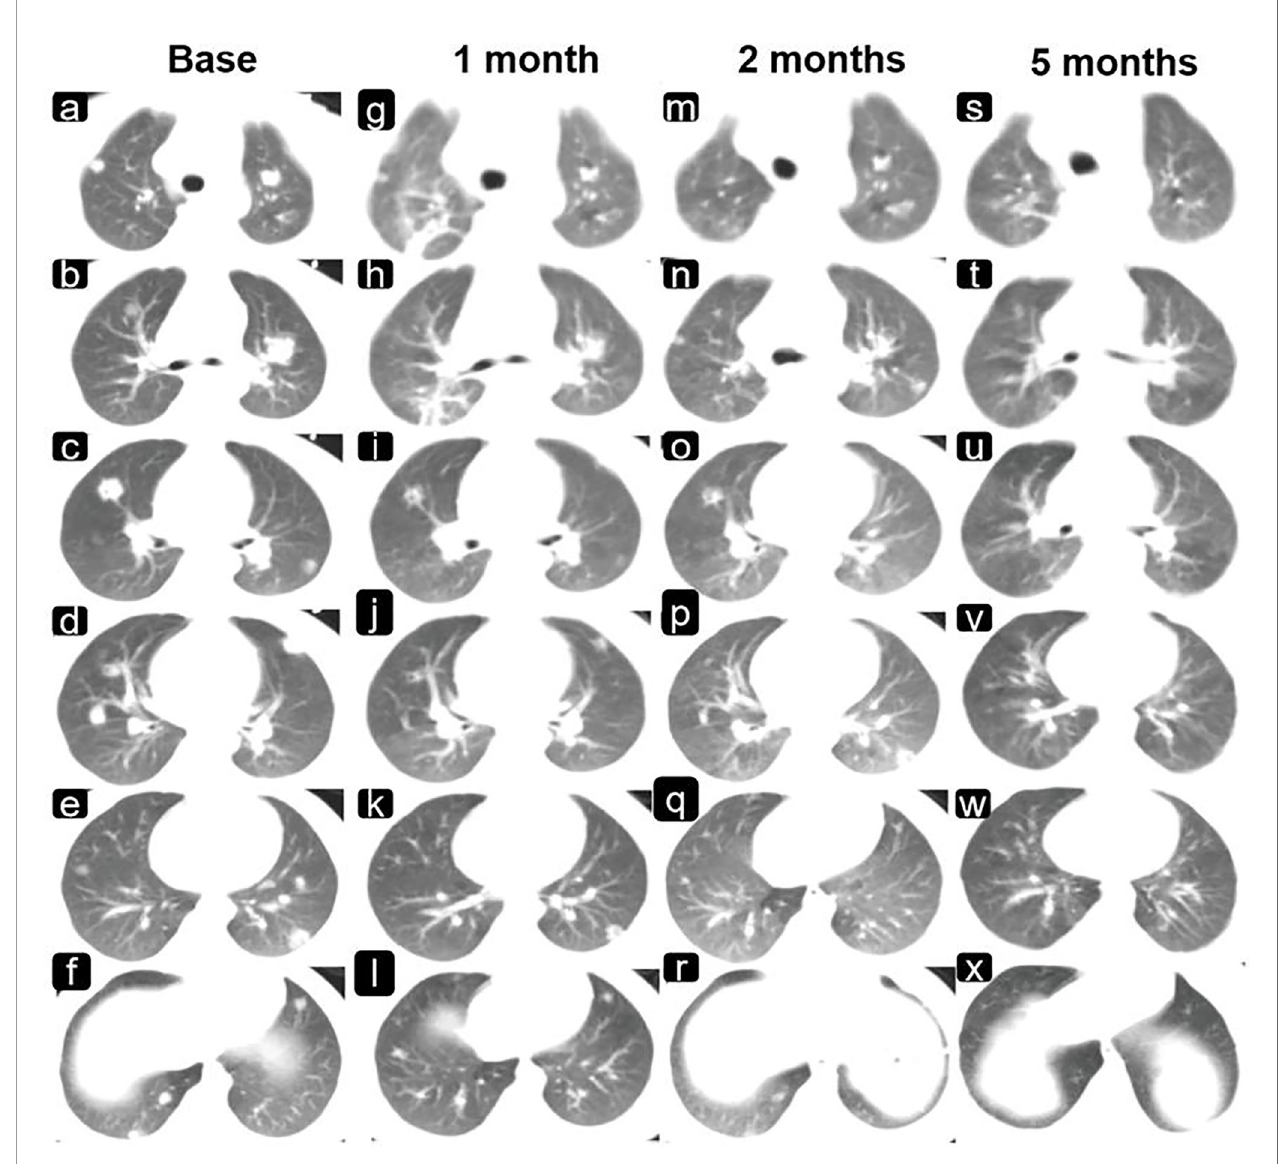
FIGURE 3 | Changes in the lung lesions are observed on imaging during chemotherapy and anti-ALK therapy. Shown are images of the lungs (A – F) before drug therapy and (G – X) after drug therapy ( G – L , 1 month; M – R , 2 months; and S – X , 5